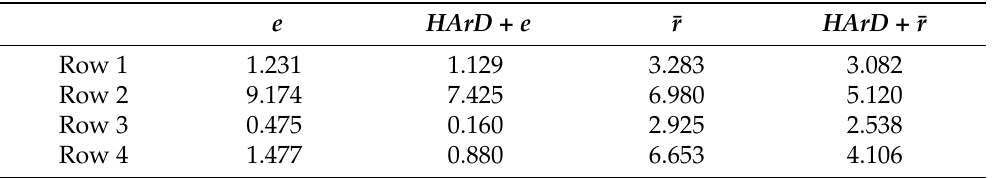
Figure 5. An example showing how the indicators e and ¯ r proposed by Hautiére et al. [15] could be deceived by the presence of artifacts. ( a ) Foggy image and the corresponding defogging with a massive presence of artifacts, ( b ) the gradients of the two images and the corresponding ratio (third row). Note that where artifacts are present, the ratio is very high. Bright red denotes a ratio larger than 10. ( c ) Visible edges in the two images and the visible edges only present in the defogging. Note that the majority of visible edges in the defogged image are in regions where artifacts are clearly present. Images are better viewed if enlarged on a computer monitor. Table 3. Values for the indicators e and ¯ r [15] and the proposed HArD + e and HArD + ¯ r metrics for the images in Figure